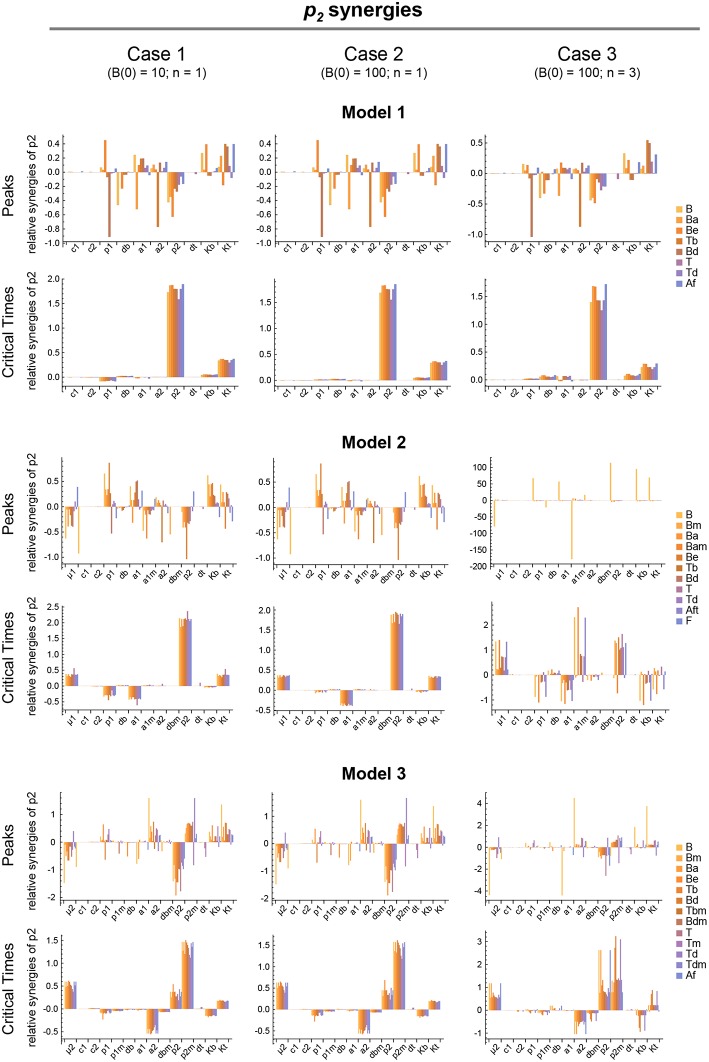
Local parameter synergy analysis of the three models. Histograms show representative results of the relative synergy between parameter p2 and all other parameters with respect to the peaks and critical times of all model variables. Upper two panels correspond to Model 1, middle panels to Model 2, and lower panels to Model 3. Left side panels (case 1), center panels (case 2), and right side panels (case 3) of the three models show the results, respectively, for B(0) = 10 and n = 1, B(0) = 100 and n = 1, and B(0) = 100 and n = 3 (see text for details). Parameter values used were the same as in Figure 3 for Model 1, Figure 4 for Model 2, and Figure 5 for Model 3.